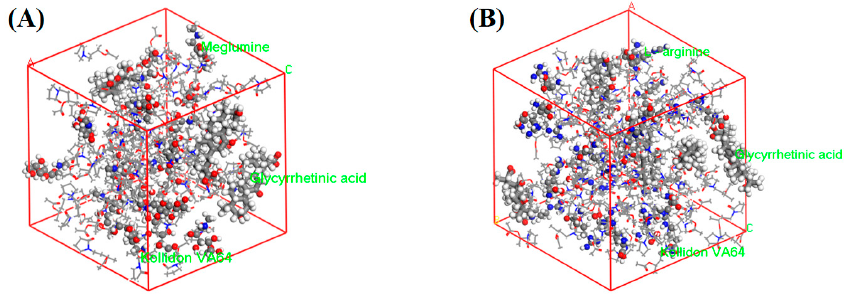
Figure 12. Snapshots of ( A ) MG-TSD and ( B ) LA-TSD systems at the end of the molecular dynamics simulation.